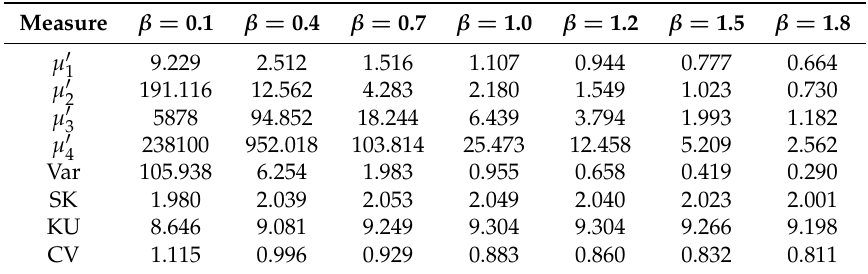
Table 3. Numerical values of some moments, variance, SK, KU, and CV of the EMIEE distribution for some selected values of β and at α = 0.5 and γ =